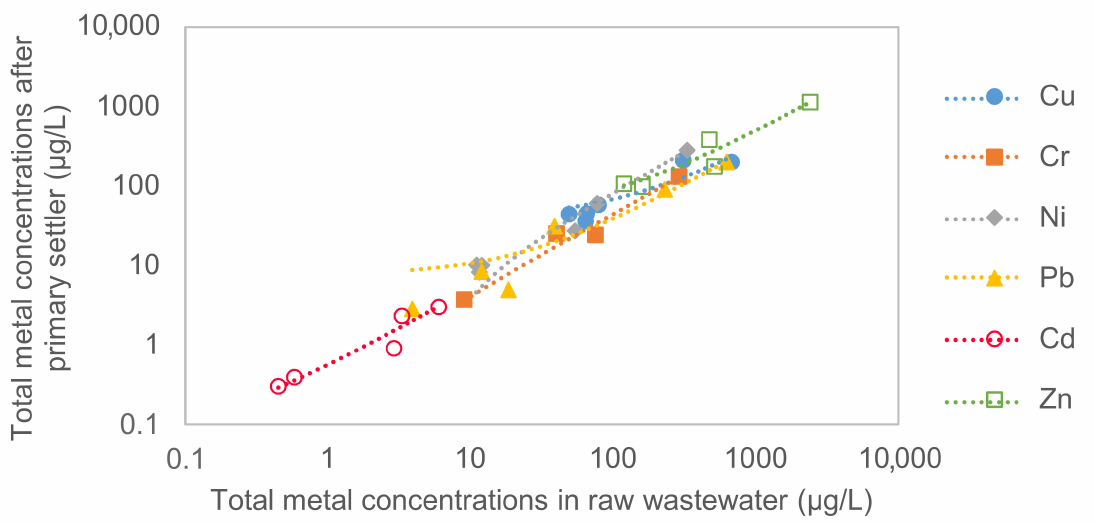
Figure 3. Total heavy metal concentrations after primary settling compared to total heavy metal concentrations in raw wastewater. [35,39,41–44,47,48]. (Sufficient data for As, Ag and Hg not available.) The dotted lines represent the linear regression between the total heavy metals concentrations in raw wastewater and total heavy metal concentrations after primary settling (R 2 values: 0.75, 0.99, >0.99, 0.99, 0.88 and 0.97 for Cu, Cr, Ni, Pb, Cd and Zn, respectively; linear relations between concentration in raw wastewater (x) and concentration after primary settler (y): y Cu = 0.29 x Cu + 39, y Cr = 0.45 x Cr − 0.42, y Ni = 0.86 x Ni − 4.9, y Pb = 0.31 x Pb + 7.5, y Cd = 0.50 x Cd + 0.067, and y Zn = 0.45 x Zn + 47; the regression for Cu is not reliable, because the R2 value is not as high as for the other metals; the regression coefficient can be taken as an estimation of the fraction of each heavy metal remaining after primary settling; the value of the intercept can be interpreted as the average amount of metals added through return flows, and negative values are therefore